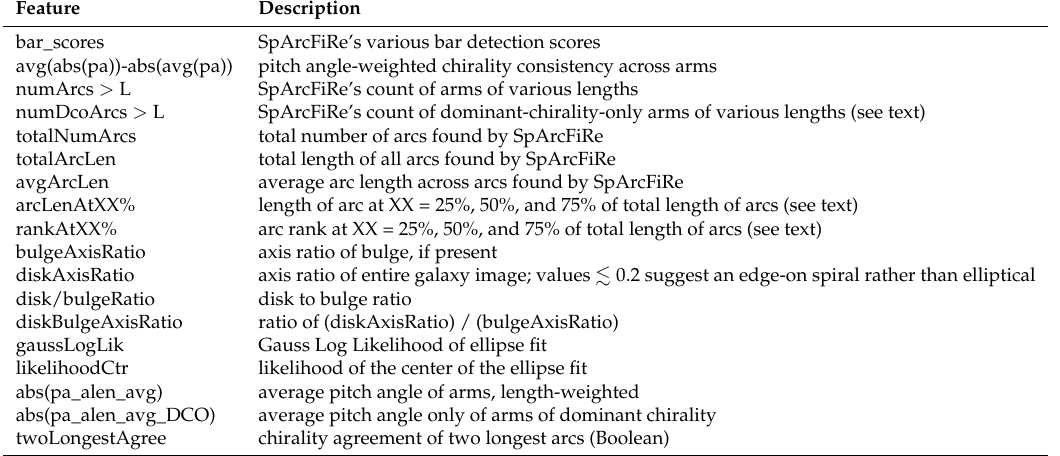
Table 3. Outputs from SpArcFiRe that are used as input features for our model, in addition to those from Table 1. See Davis and Hayes [15] for full descriptions of these parameters. Parameters labeled “DCO” are measured only across arcs of “dominant chirality only”—that is, arcs of the “wrong” chirality, which are likely to be noise, are not included. The parameter “arcLenAt50%” means: lay arcs end-to-end sorted longest to shortest, resulting in a line of total length L, and measure the length of the arc that lies at the point L/2 along the line. If the arms are short at L/2, then short arcs tend to suggest the galaxy is either flocculent or non-spiral, whereas a long arc at this point suggests a more grand-design spiral. The “rankAt50%” feature is similar, except this is the integer rank of the arc touching the L/2 point. If the ratio ((diskAxisRatio) / (bulgeAxisRatio)) is close to 1, it is suggestive of an elliptical galaxy, whereas if this ratio is significantly less than one it suggests a spiral galaxy (since the bulge axis ratio tends to be 1 from any vantage point, but not so for the